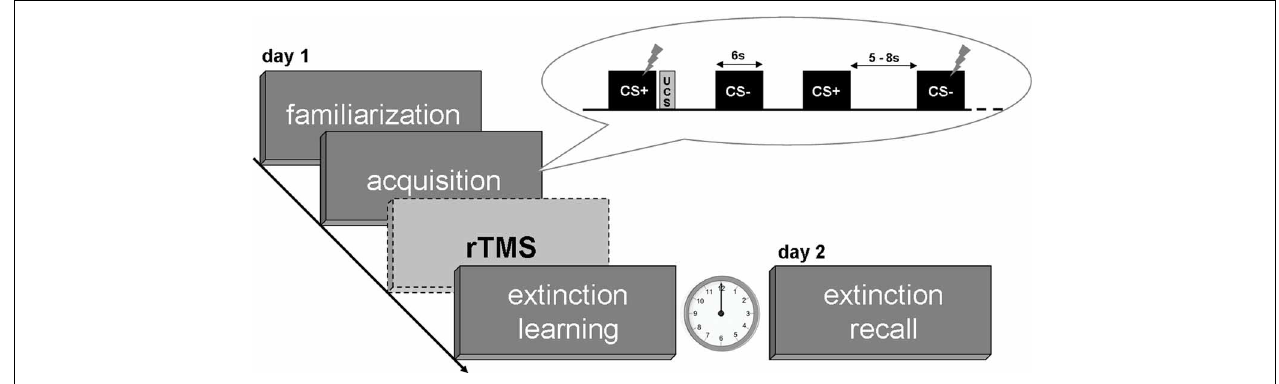
FIGURE 1 | Experimental design. Flashes indicate startle stimuli during CS presentations as primary measure of the conditioned